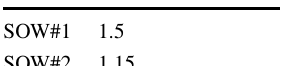
water in each shale oil well in MMSCF/Day during hydraulic fracturing